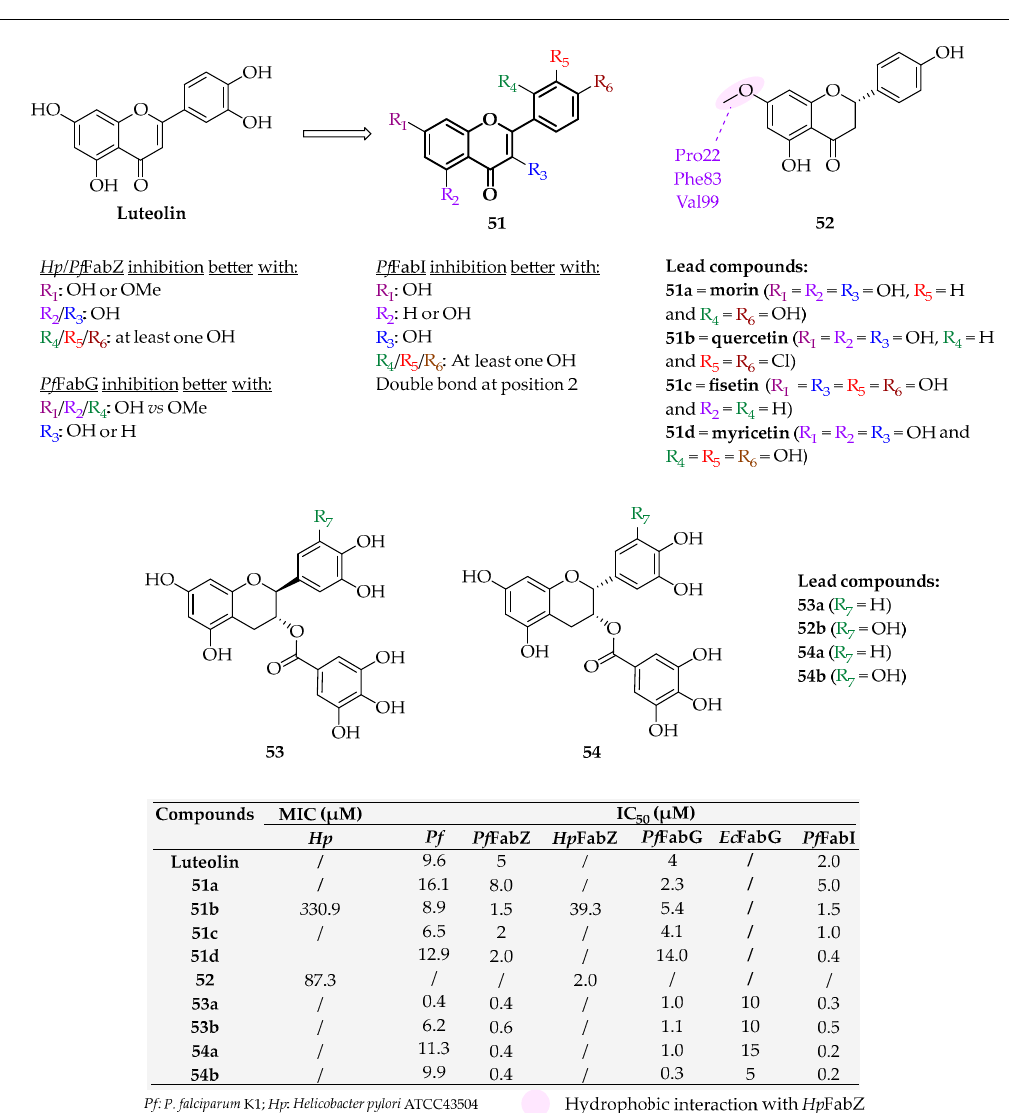
Figure 43. Structure, SAR and representation of main interactions with Hp FabZ of flavonoids 48–51 and in vitro activities of lead compounds [103,173,174,176].